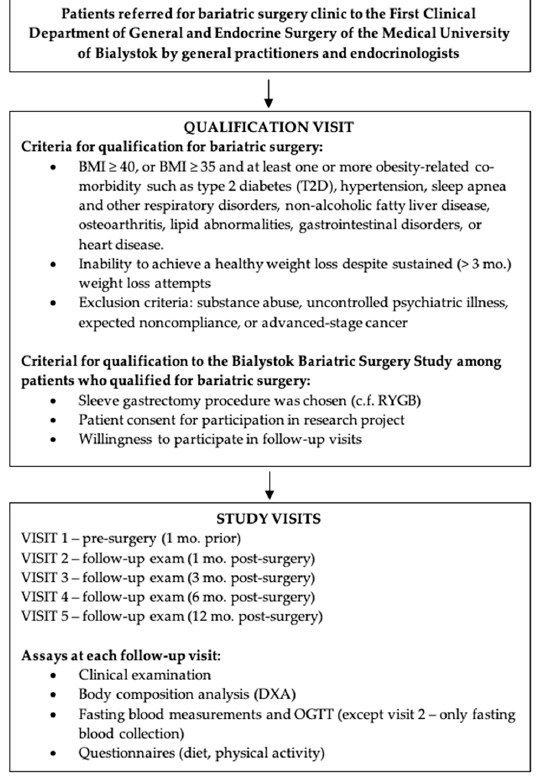
Figure 1. Qualification procedure and criteria for this study.